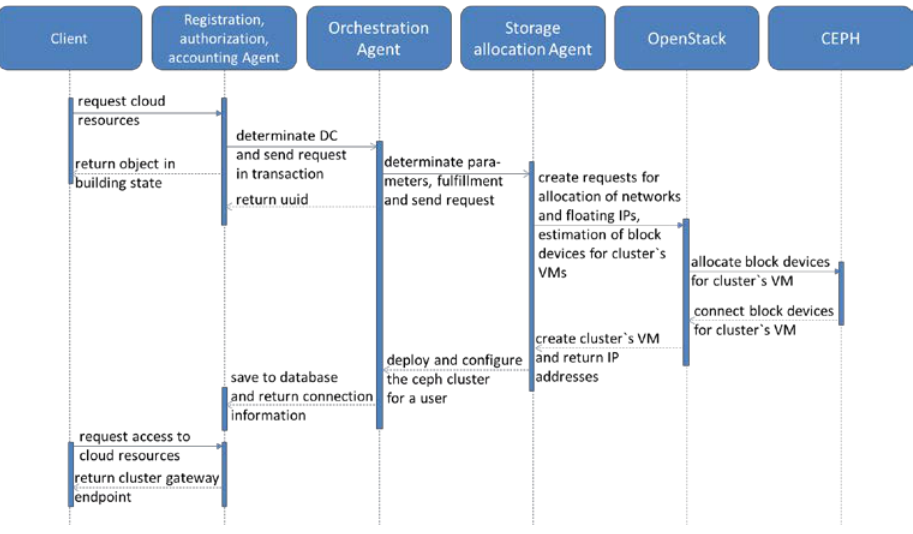
Fig. 3. User storage cluster creation sequence diagram